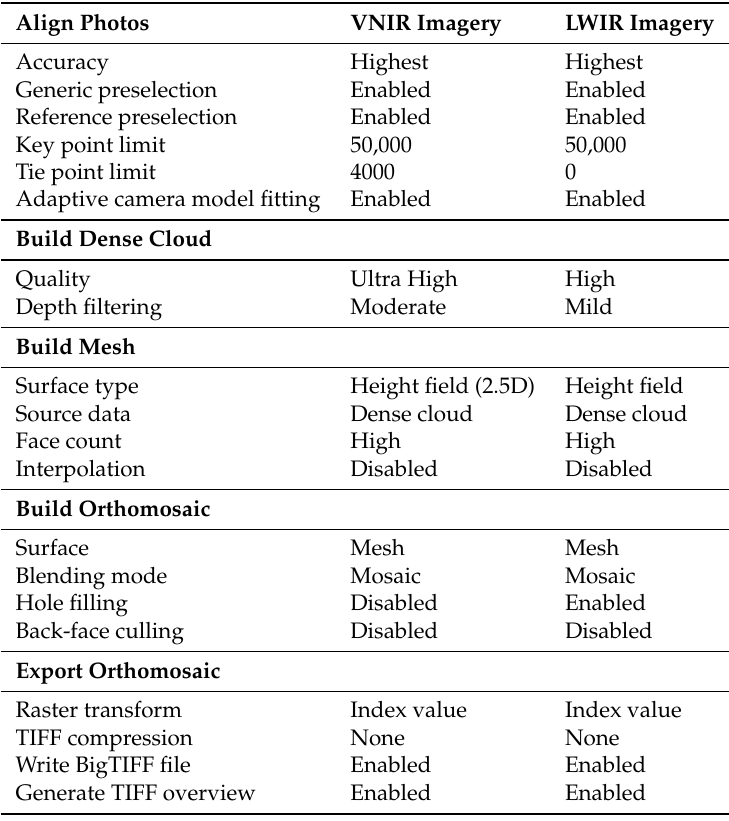
Table A2. Tools and parameters selected for ortho-mosaic